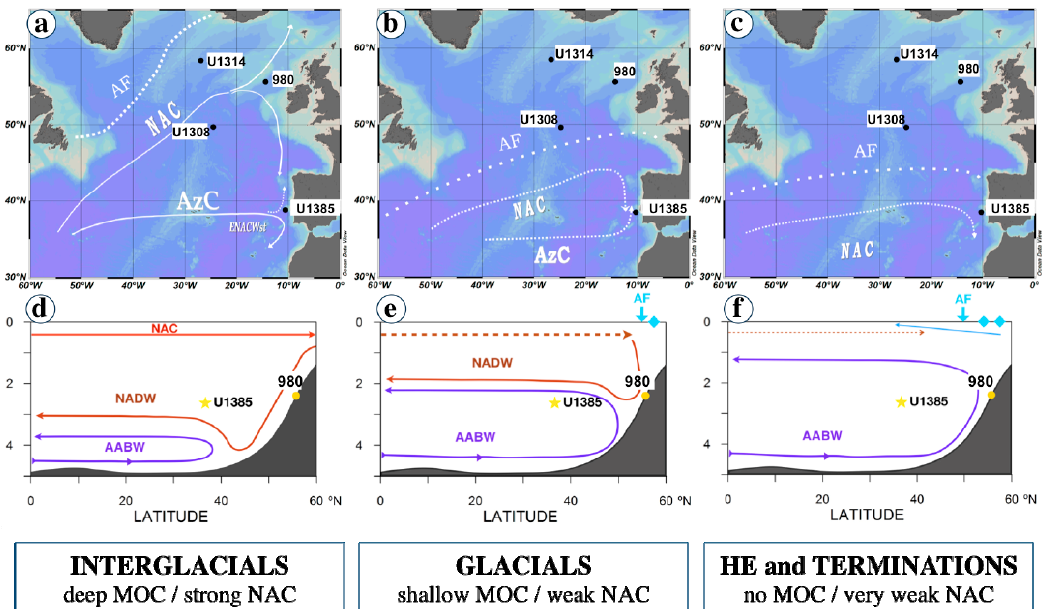
Figure 6. In the upper panel, variations in the position of the artic front (AF) and paths of surface currents during; ( a ) interglacials, ( b ) glacials, and ( c ) terminations and Heinrich events. (References in the text). In the lower panel, meridional overturning circulation (MOC) modes along the Quaternary. ( d ) The position of the AF north of 60° N during interglacials favored a vigorous North Atlantic Current (NAC) and a deep MOC. ( e ) Iceberg surges and the southern position of the AF reduced the North Atlantic Deep Water (NADW) formation rate, which resulted in a shallow overturning cell and weak NAC. ( f ) Extremely weak surface circulation resulted from peak southward migrations of the AF and null NADW formation. Sites ODP-980 (55°29´ N; 14°42´ W; 2168 m depth) and IODP-U1385 (37°34´ N; 10°7´ W; 2589 m depth) have been plotted to illustrate the position of NADW and Antarctic Bottom Water (AABW) (data from [36,60]). Cyan diamonds and line, in ( e – f ), represent icebergs and fresh-water,